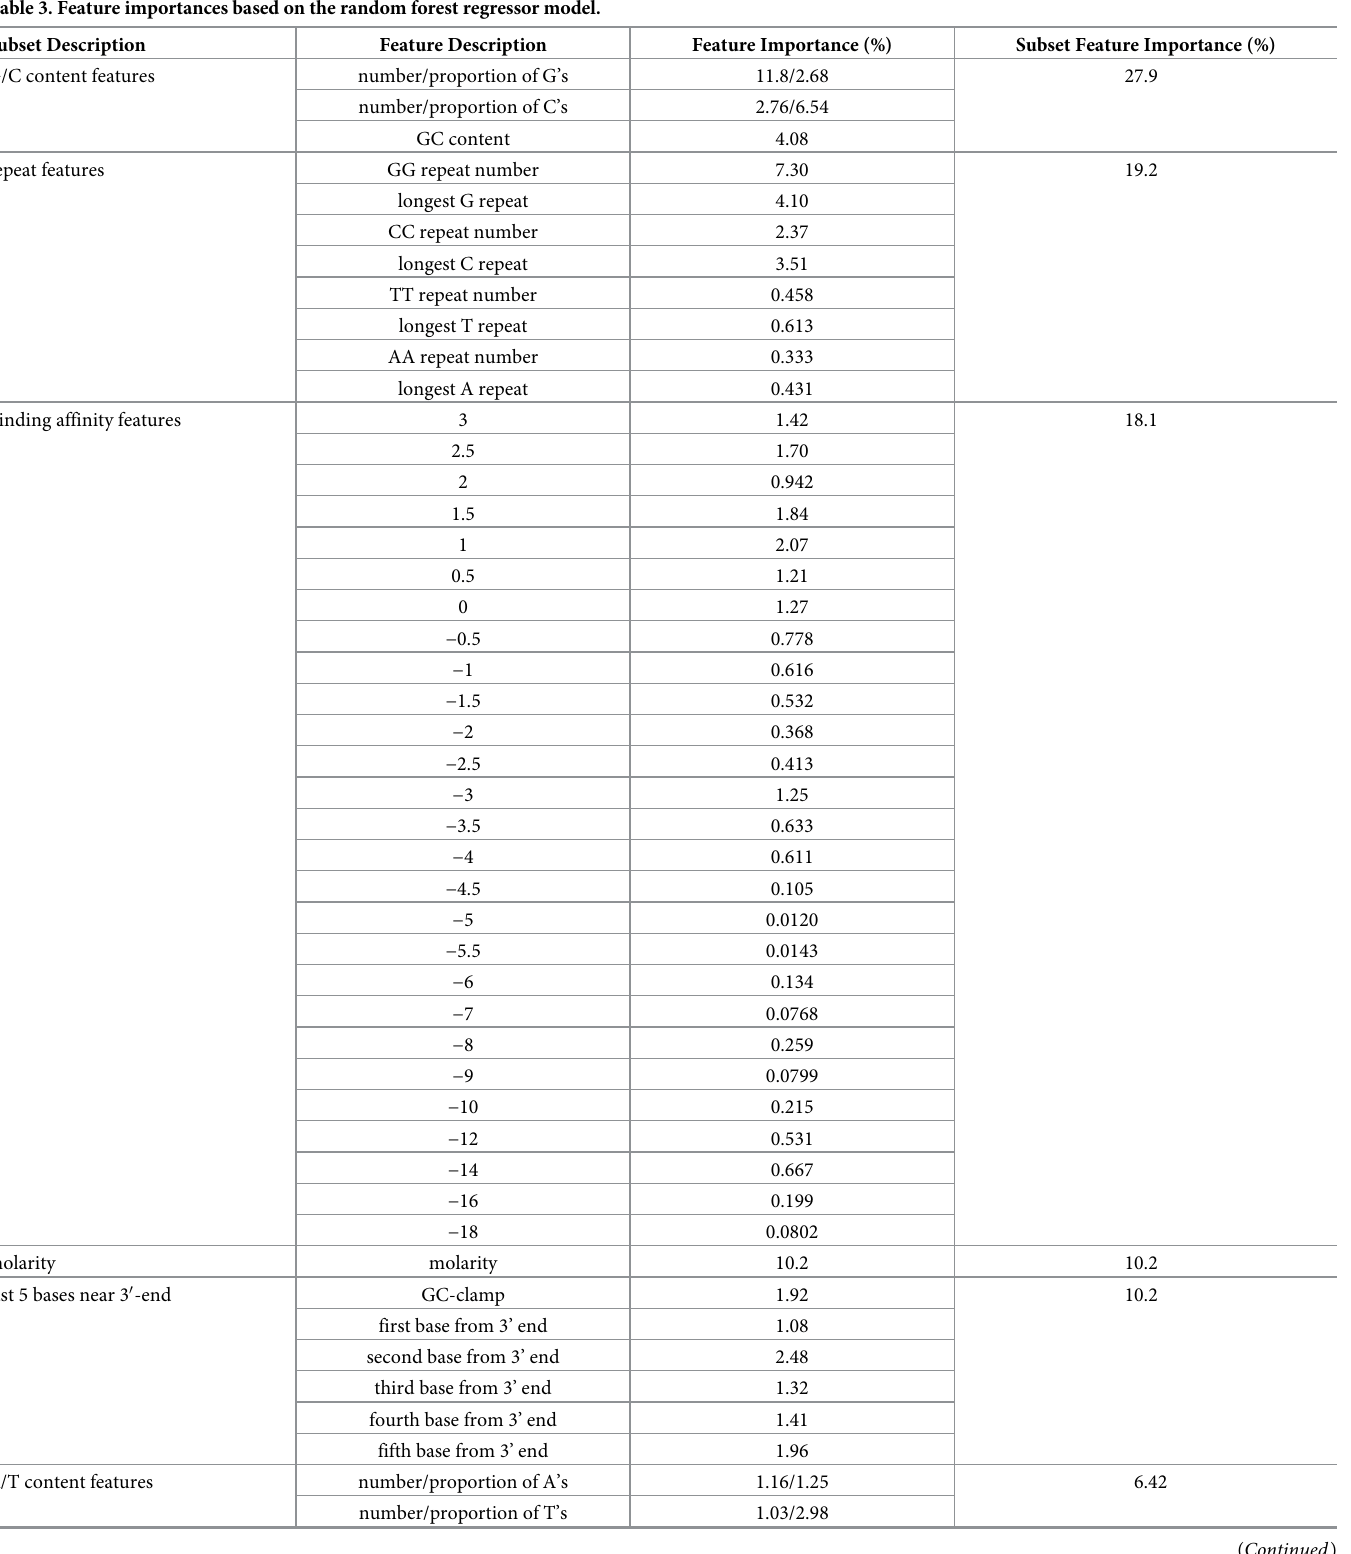
Table 3. Feature importances based on the random forest regressor